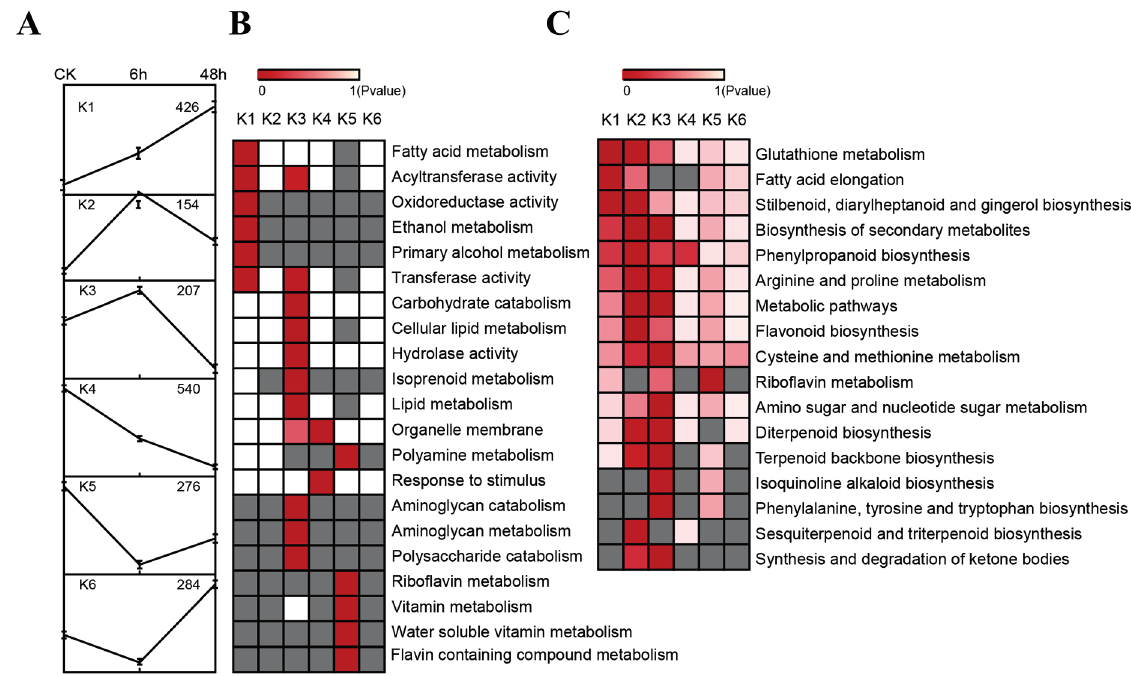
Figure 3. The dynamic profiles of all differentially expressed genes in tobacco roots on response to drought stress. ( A ) K -means clustering showing the expression profile of 1887 differentially expressed genes. Six clusters were identified in NCK, N6H and N48H from these genes above. These clusters are presented in A . Error bars show standard deviation; ( B ) Analysis of functional category enrichment among the six major clusters; ( C ) Analysis of pathways enrichment among the six major